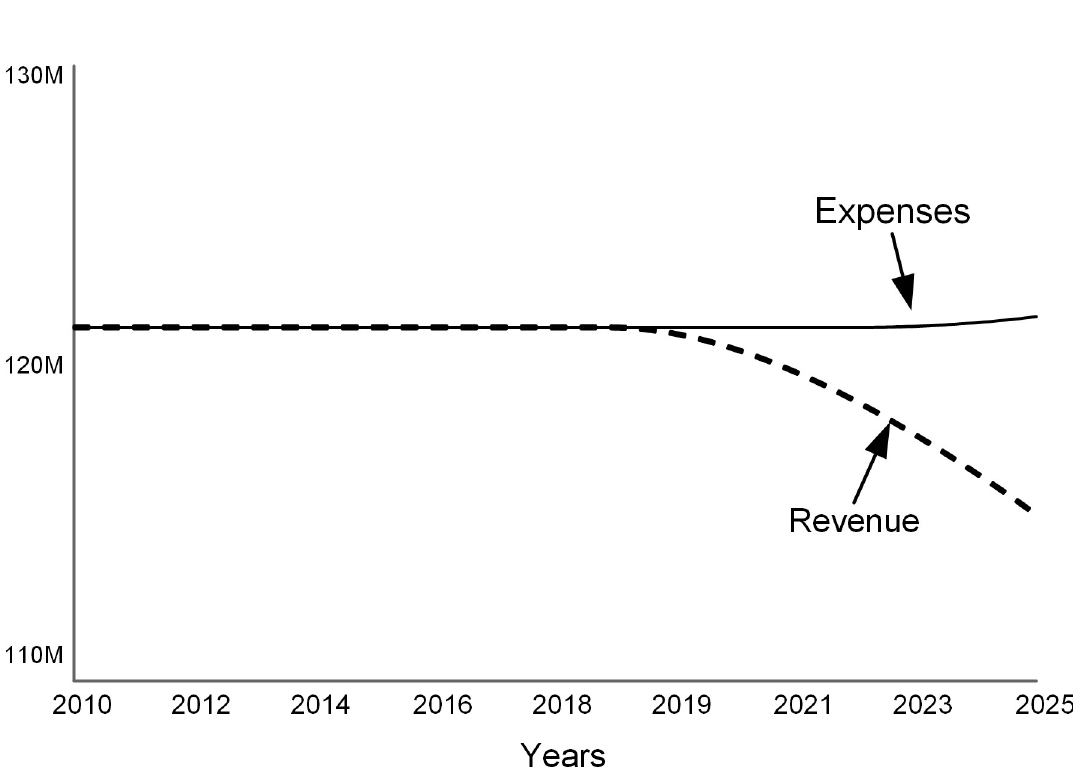
Fig 10. Revenue and